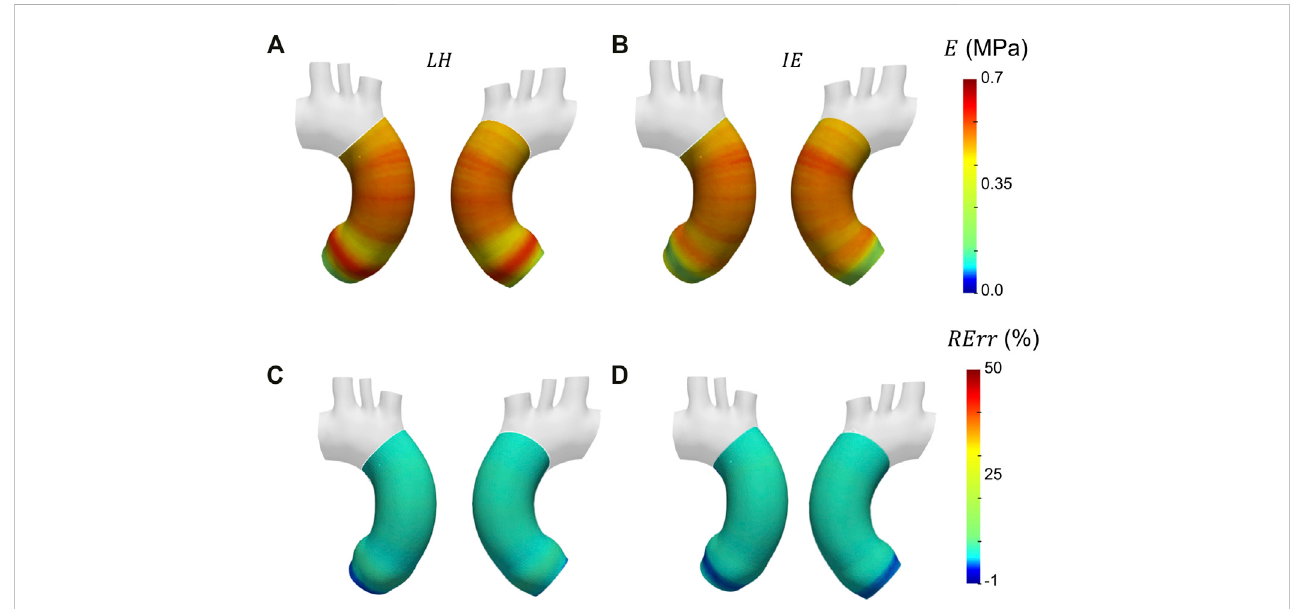
FIGURE 6 Young ’ s modulus maps of FE validation for patient-speci fi c geometry with homogeneous distribution with (cid:1) E H θ (cid:2) 0.5 MPa (A, B) with corresponding relative errors (C, D) . Both Laplace-hypothesis-based ( E LH θ ) (A, C) and inverse-engineering-based ( E IE θ ) (B, D) results are presented.